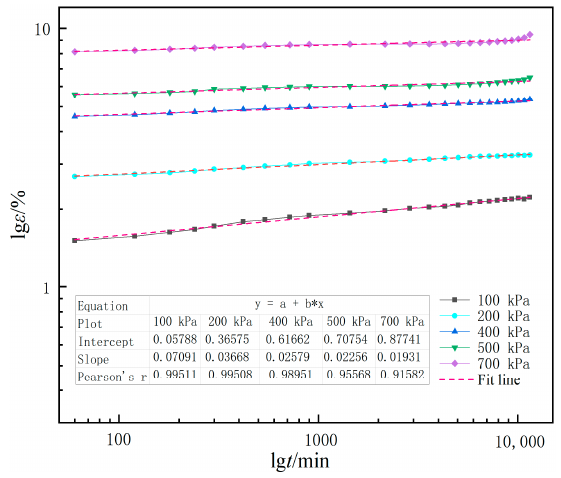
Figure 9. lg ε -lg t relation of Changsha sand soil and its linear fi tt ing curve.